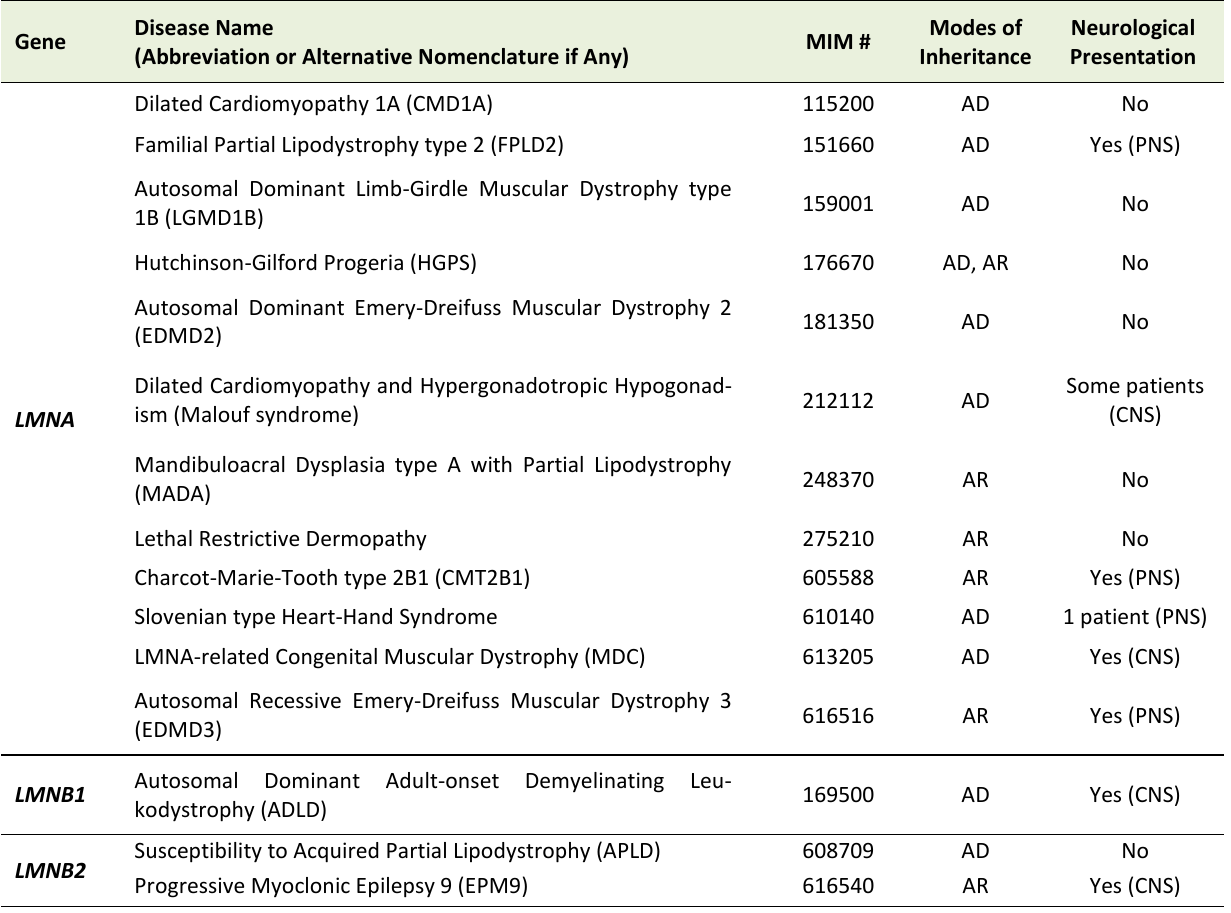
TABLE 1. List of human laminopathies that are caused by mutations in Lamin genes. Disease Gene